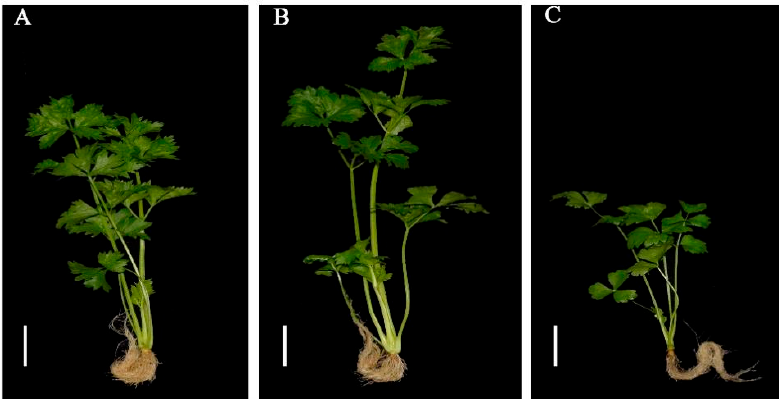
Figure 3. Effects of DCB treatments on celery growth, with celery at 65 DAG. ( A ) Control; ( B ) 2.32 × 10 − 5 mol/L DCB treatment; ( C ) 3.49 × 10 − 5 mol/L DCB 24 ‐ EBL treatment; ( D ) 4.65 × 10 − 5 mol/L DCB treatment; ( E ) 5.81 × 10 − 5 mol/L DCB treatment. Scale bars = 5 cm. 3.2. Effects of 24 ‐ EBL, PCZ and DCB Treatments on Length of Petioles, Number of Leaf Blades and Cell Length of Petioles in Celery The leaf blade number, petioles length and petiole cell length of celery treated with 24 ‐ EBL were increased, and those treated with PCZ and DCB were decreased compared to that of the control (Figure 4). Under 1.24 × 10 − 6 mol/L 24 ‐ EBL treatment, the leaf blade number and petioles length peaked at 50 DAG and were 1.37 ‐ and 2.16 ‐ fold those of the control, respectively (Figure 4A,B). The largest length of petiole cell was 153.72 μ m in the 1.66 × 10 − 6 mol/L 24 ‐ EBL treatment group and was 1.54 ‐ fold that of the control (Figure 4C). The leaf blade number was 13.25 under 2.32 × 10 − 5 mol/L DCB treatment group, which was 0.76 ‐ fold that of control. The shortest petiole length and petiole cell length were 18.56 cm and 84.05 μ m under 3.49 × 10 − 5 and 4.65 × 10 − 5 mol/L DCB treatment groups, which were 0.65 ‐ and 0.57 ‐ fold of that in the control group, respectively (Figure 4D–F). Celery treated with 1.24 × 10 − 6 mol/L 24 ‐ EBL showed the largest number of leaf blades (17.8), the longest length of petiole (29.35 cm) and longest petiole cells (181.59 μ m) at 60 DAG (Figure 4G–I).